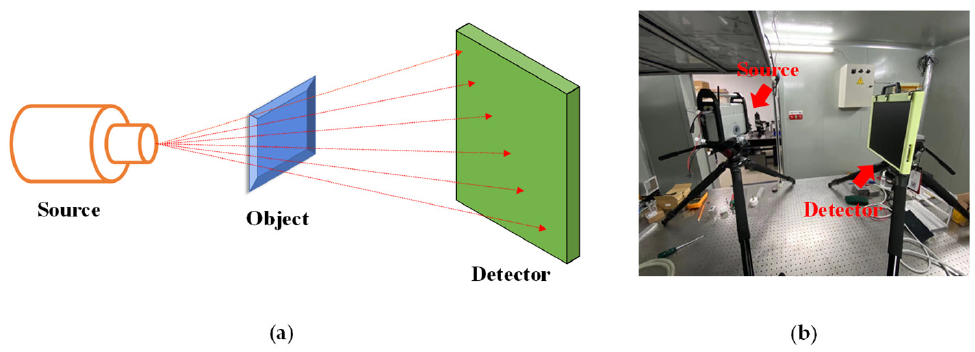
Figure 8. ( a ) Set-up for penetration imaging; ( b ) experimental Figure 8. ( a ) S et-up for penetration imaging; ( b ) experimental system.